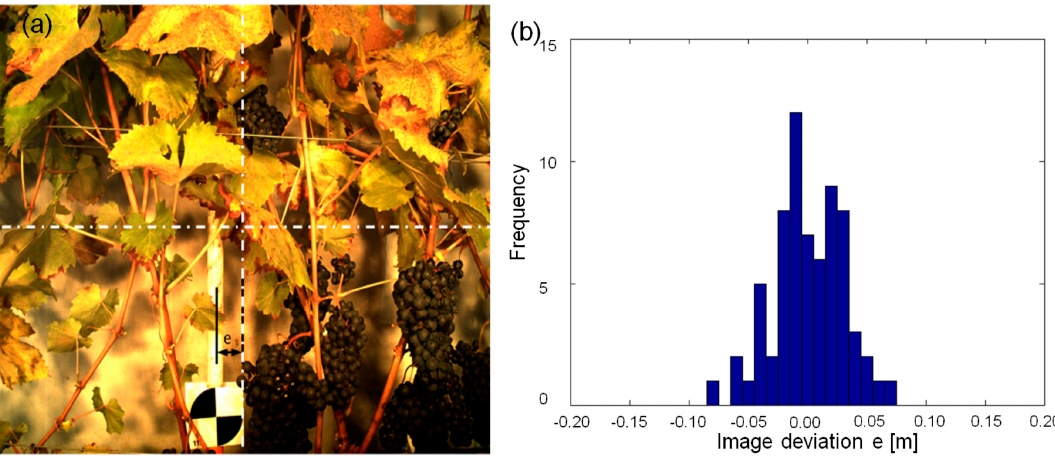
Figure 4. Experiment set up of POIs at the position of vine stems. ( a ) Image, selected as the one closest to an POI, with the deviation e as the error of the selection process. ( b ) Distribution of deviations from 10 runs at different speeds.